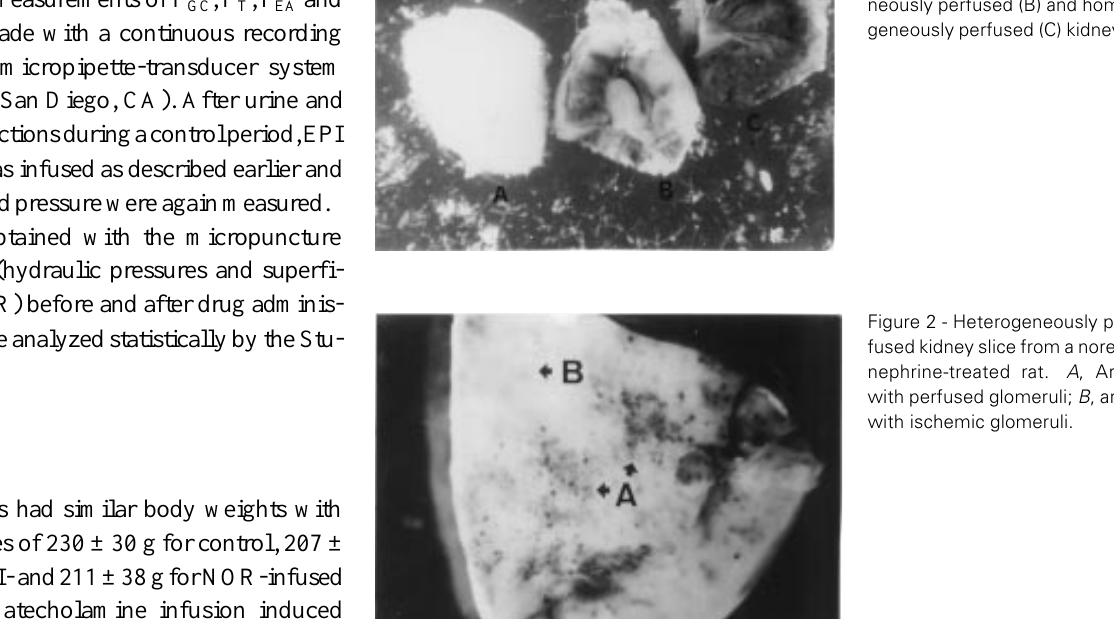
Figure 1 - Qualitative distribution of Prussian blue in homoge- neously ischemic (A), heteroge- neously perfused (B) and homo- geneously perfused (C) kidneys.